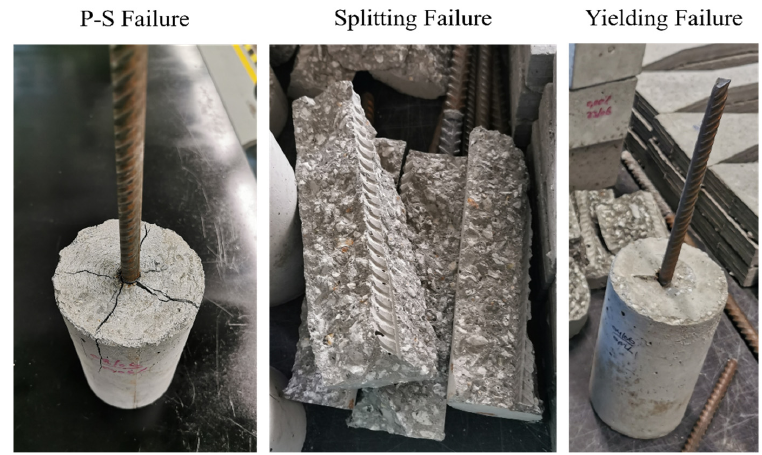
Figure 8. Pullout test samples with various failure mechanisms.